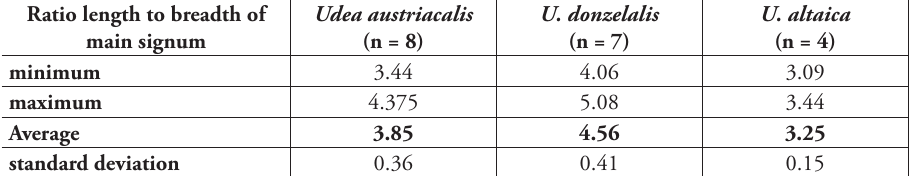
Table 1. Ratios of length versus breadth of the main signum of female genitalia in selected species of the Udea alpinalis species